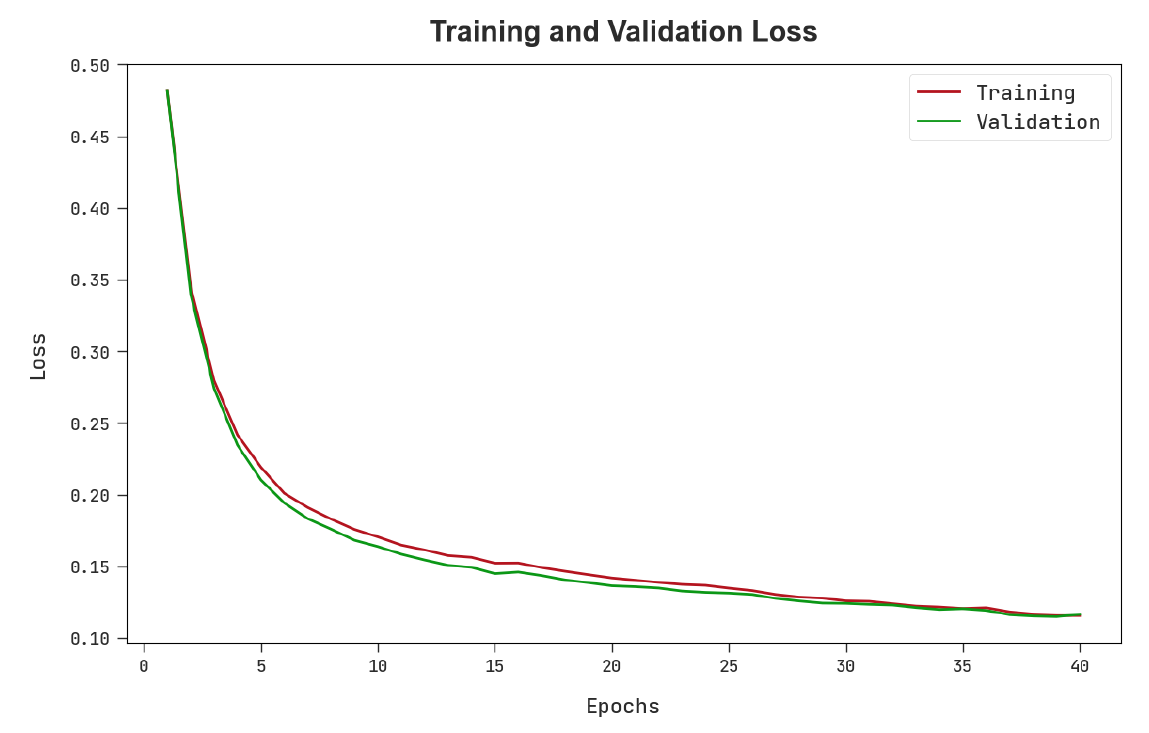
Figure 10. TLOS and VLOS outcomes of the MPADL-LC3 algorithm.